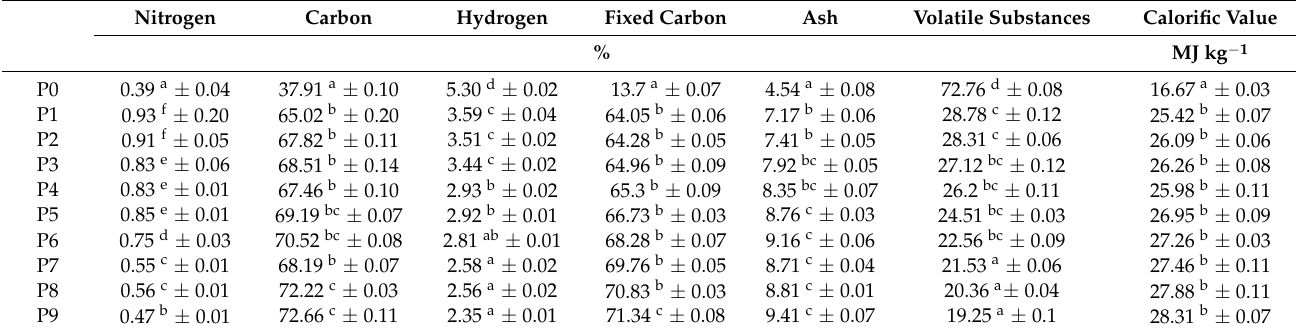
Table 5. Contents of total nitrogen, total carbon, hydrogen, fixed carbon, ash, volatile substances, and calorific value in non-processed biomass of pear branches and in the biochars